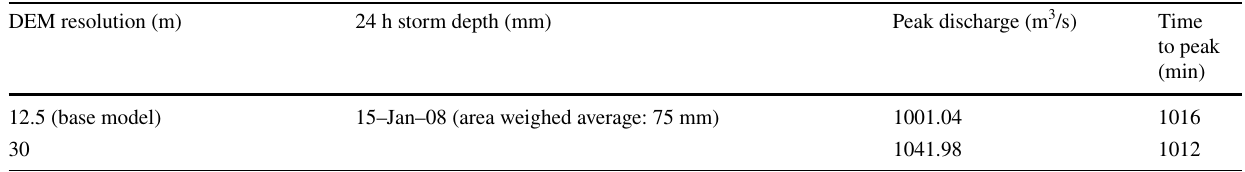
Table 3 Flood properties of calibrated GSSHA base model for flood event of January 15, 2008, compared to corresponding properties of GSSHA model developed based on DEM with the resolution of 30